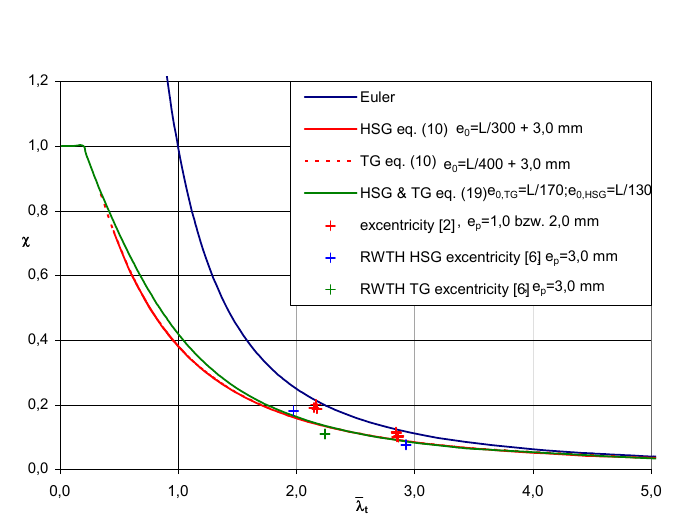
Figure 9: Comparison of the analytic buckling curves for monolithic glass columns to the experimental test results with excentricity e p . If the effective